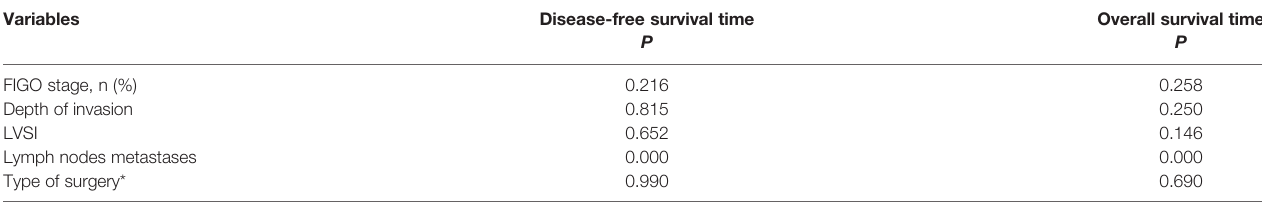
TABLE 2 | Multivariate analysis for disease-free survival and overall survival. Variables